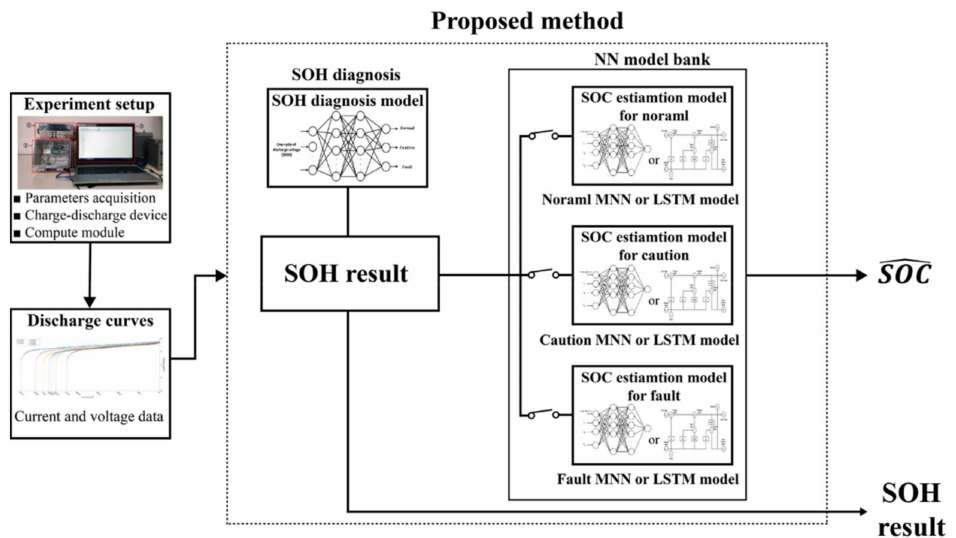
Figure 2. Structure of the proposed